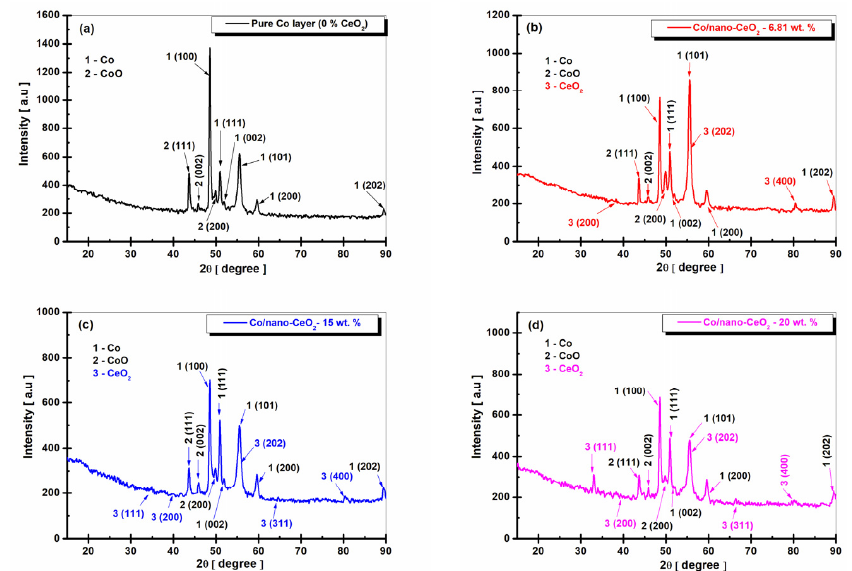
Figure 3. XRD patterns of electrodeposited layers obtained at a current density of 23 mA cm − 2 : ( a ) pure Co layer (0 wt. % CeO 2 ), ( b ) Co/nano-CeO 2 —10 g/L layer (6.81 wt. % CeO 2 ), ( c ) Co/nano- CeO 2 —20 g/L layer (15 wt. % CeO 2 ), and ( d ) Co/nano-CeO 2 —30 g/L layer (20 wt. % CeO 2